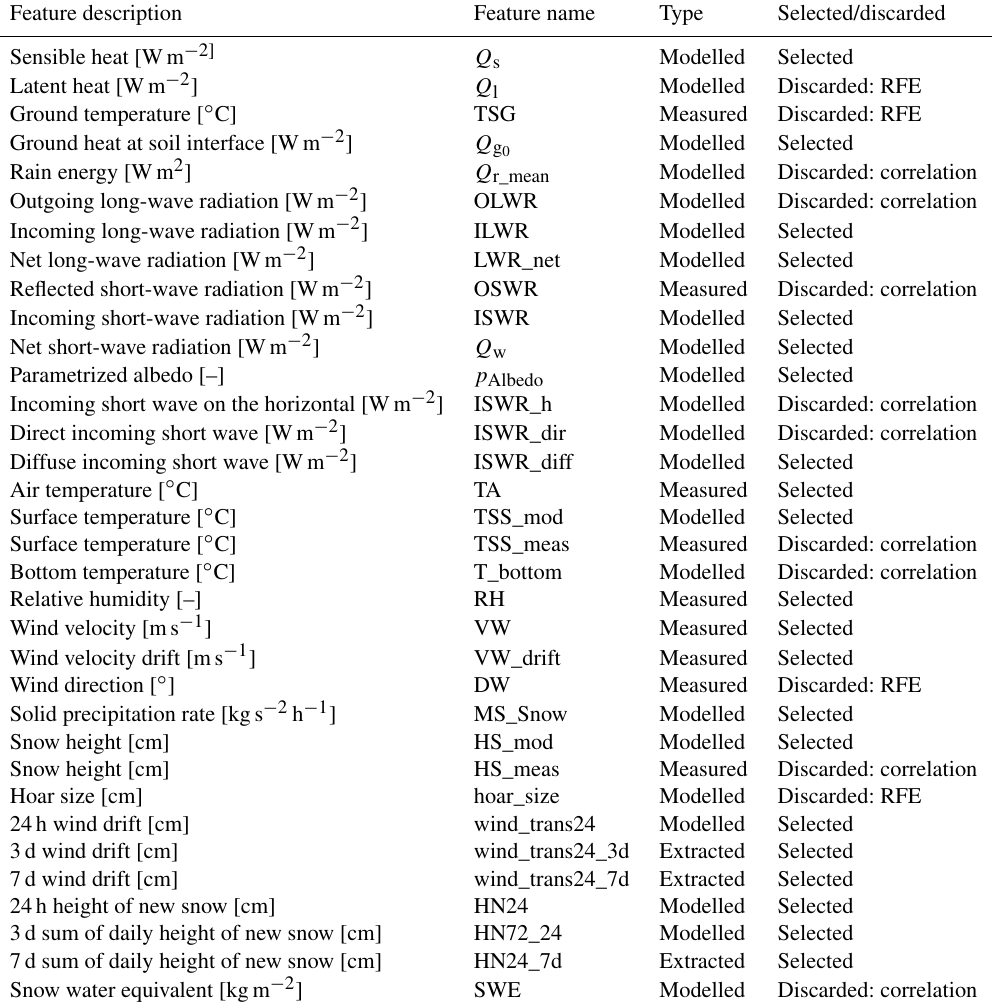
Table C1. Meteorological variables used for training the random forest algorithm. The three types of feature are the measured meteoro- logical variable, modelled meteorological variable by SNOWPACK, and extracted variable. Features can be discarded by recursive feature elimination (RFE), manually, or because they are highly correlated with another